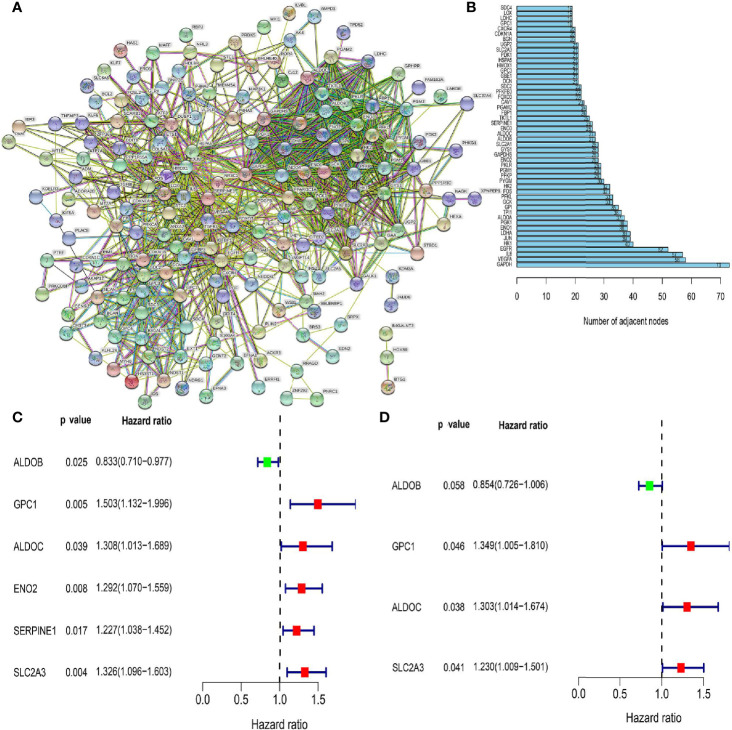
Screening for hypoxia-related genes and their relationship with patient prognosis. (A) Protein-protein interaction network containing members with interaction confidence values >0.4. (B) The top 50 genes selected based on the number of nodes and their sub-nodes. (C) Univariate Cox regression analysis identified candidate genes with p-values <0.05. (D) Among the genes related to colorectal cancer prognosis, the genes shown are those independently related to patient prognosis in a multifactor prognostic model of hypoxia.